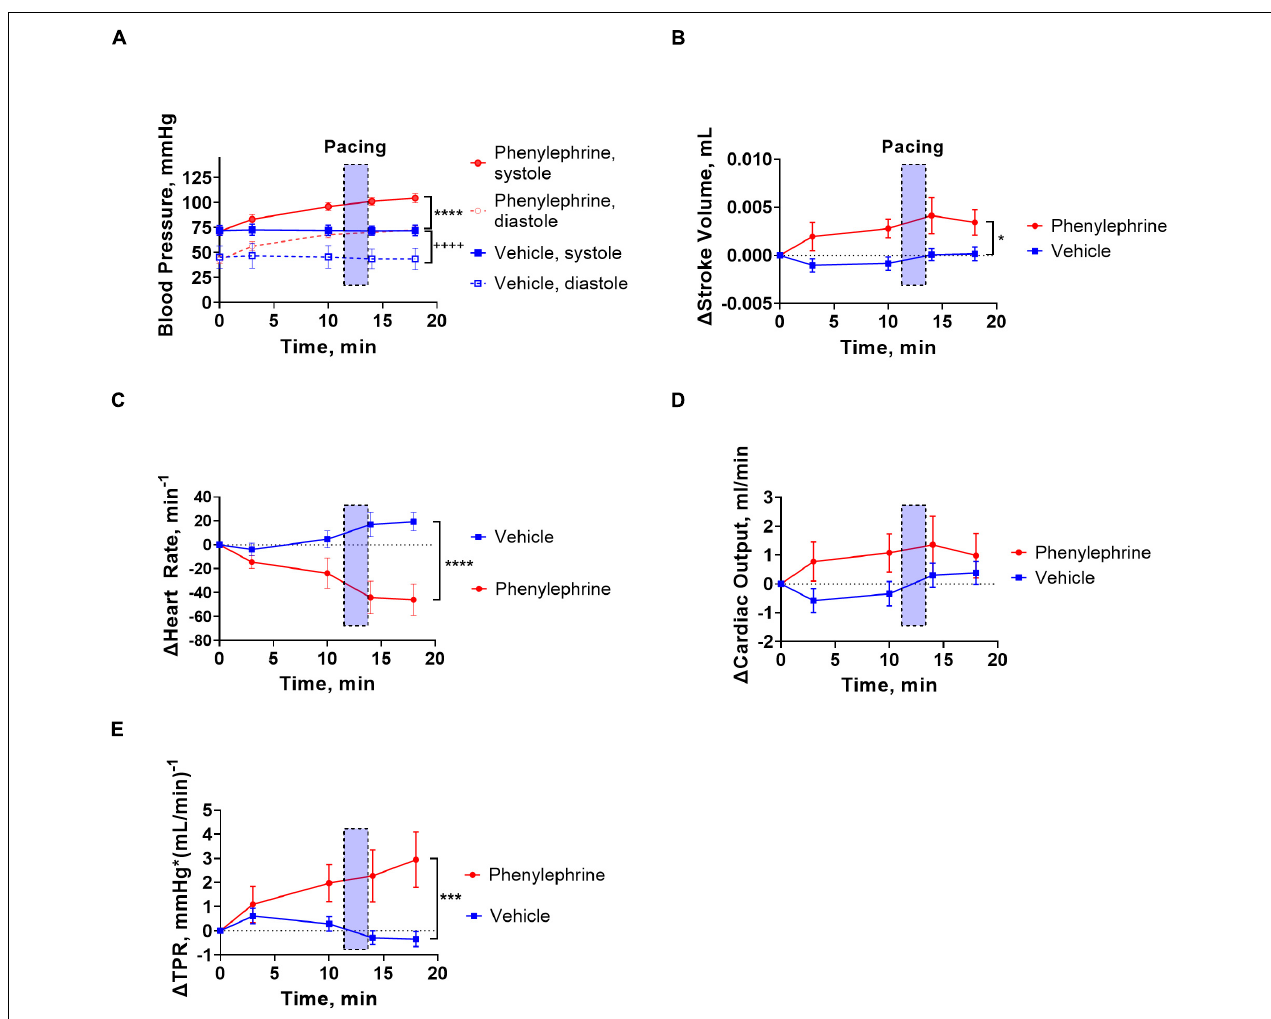
FIGURE 4 | Vehicle or phenylephrine injection was given at the beginning of the traces ( x = 0). Transparent blue boxes indicate the second pacing session corresponding to the panels in Figures 3E,H . (A) Following intervention with phenylephrine or vehicle, both systolic and diastolic blood pressures were significantly elevated in the phenylephrine group (**** P < 0.0001 systolic pressure and ++++ P < 0.0001 for diastolic pressure). (B) Stroke volume was also increased significantly following phenylephrine administration (* P = 0.027). (C) Heart rate was significantly decreased after phenylephrine administration in comparison with vehicle (**** P < 0.0001). (D) Cardiac output was not changed significantly following phenylephrine administration ( P = 0.21). (E) After phenylephrine administration, total peripheral resistance (TPR) significantly increased compared to vehicle group (*** P = 0.0006). Data were compared with two-way ANOVA, n =